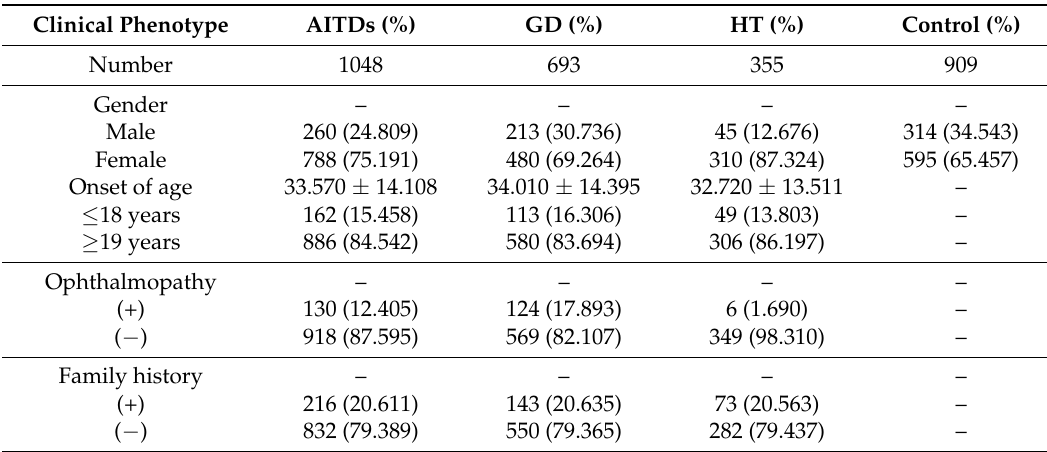
Table 1. Clinical data of AITDs patients and